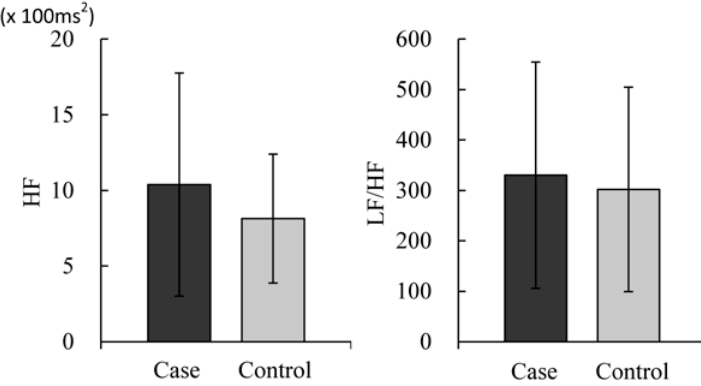
Figure 5. Fatigue degree and secretions in saliva.